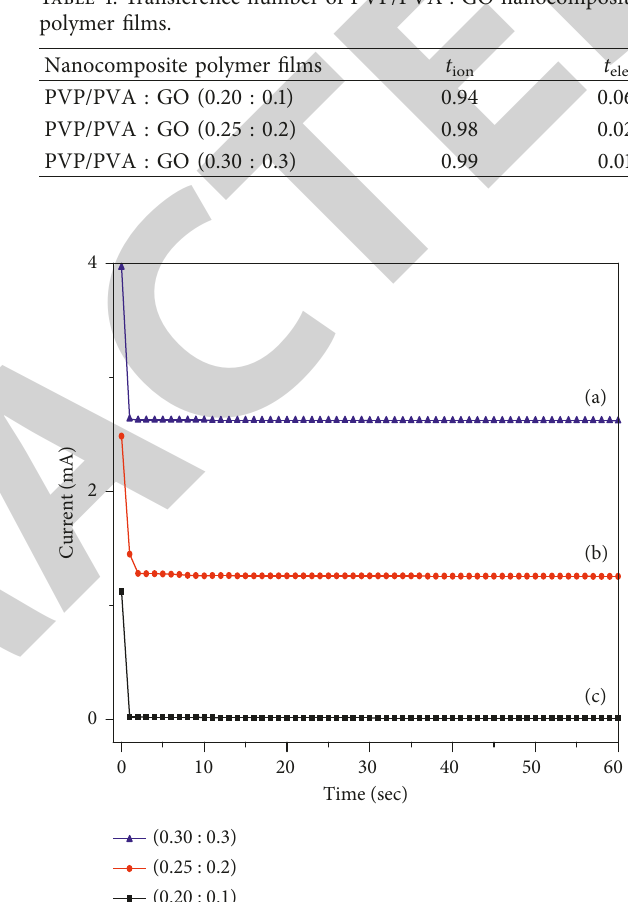
Figure 10: Transference number of polymer electrolyte films for different PVP/PVA : GO wt.% ratios of (0.20 : 0.1), (0.25 : 0.2), and (0.30 :